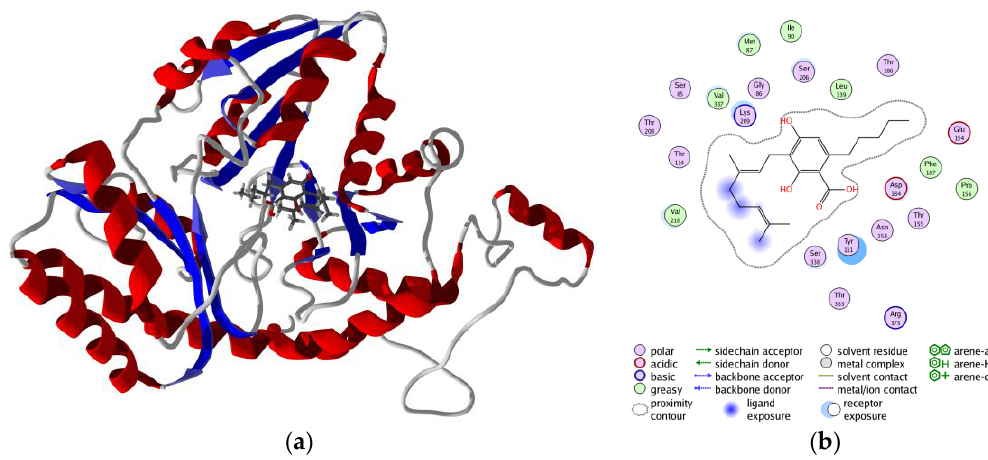
Figure 11. Lowest-energy docked pose of cannabigerolic acid with Trichomonas vaginalis methionine gamma-lyase (TvMGL): ( a ) ribbon diagram of TvMGL with cannabigerolic acid; ( b ) ligand-receptor interaction map of cannabigerolic acid with TvMGL.